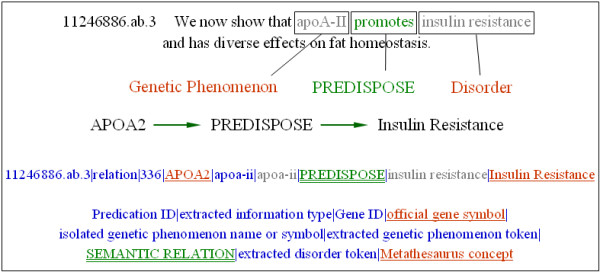
Example of SemGen gene-disease semantic relation and SemGen output fields. SemGen output includes semantic relation in green, double underlined; arguments in red, single underlined; extracted genetic phenomenon and disorder tokens in gray.